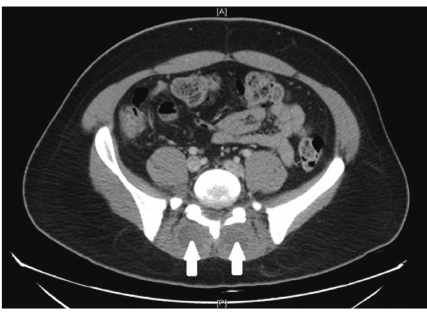
Figure 1: CT of the abdomen with two arrows showing the areas of low-density within the posterior paraspinal muscles.